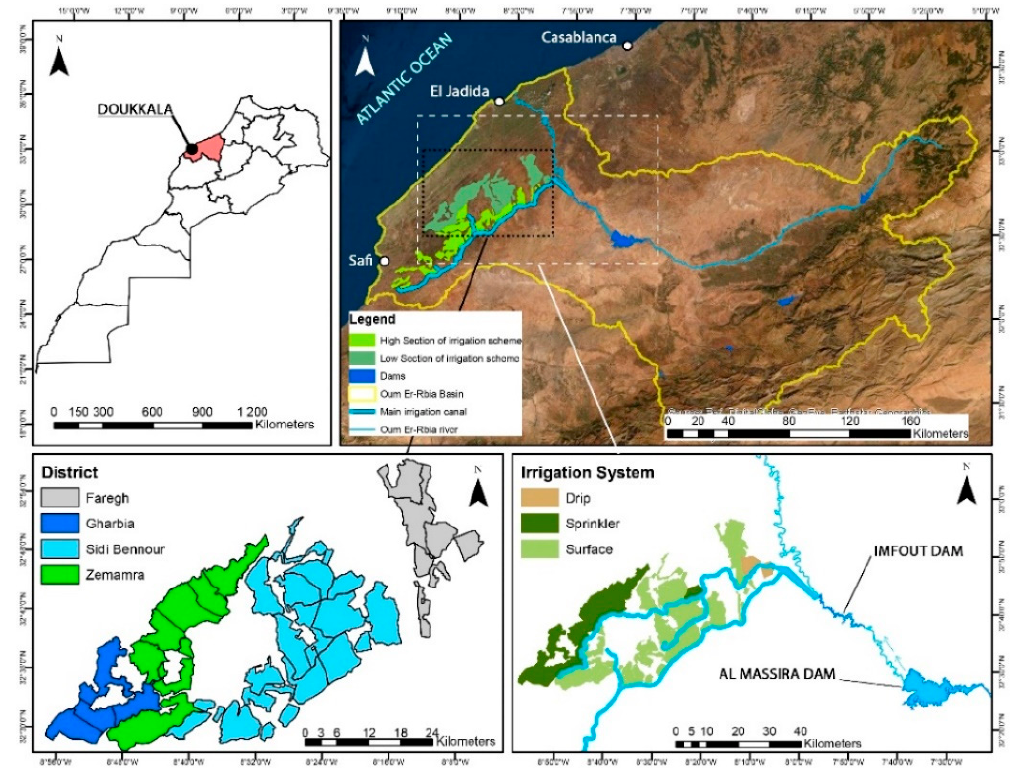
Figure 1. Location map of the study area: the Doukkala irrigation scheme .